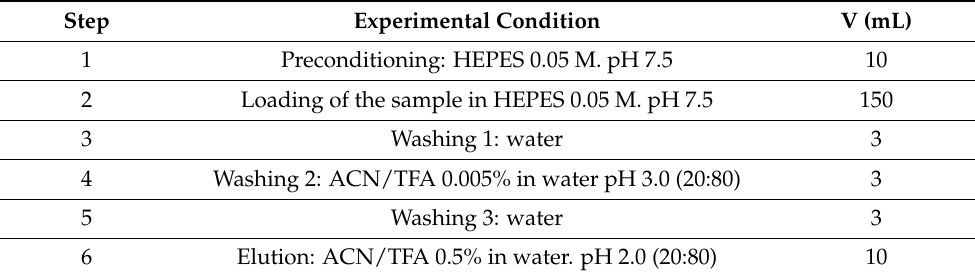
Table 1. Preconcentration steps for the online MISPE analysis of water